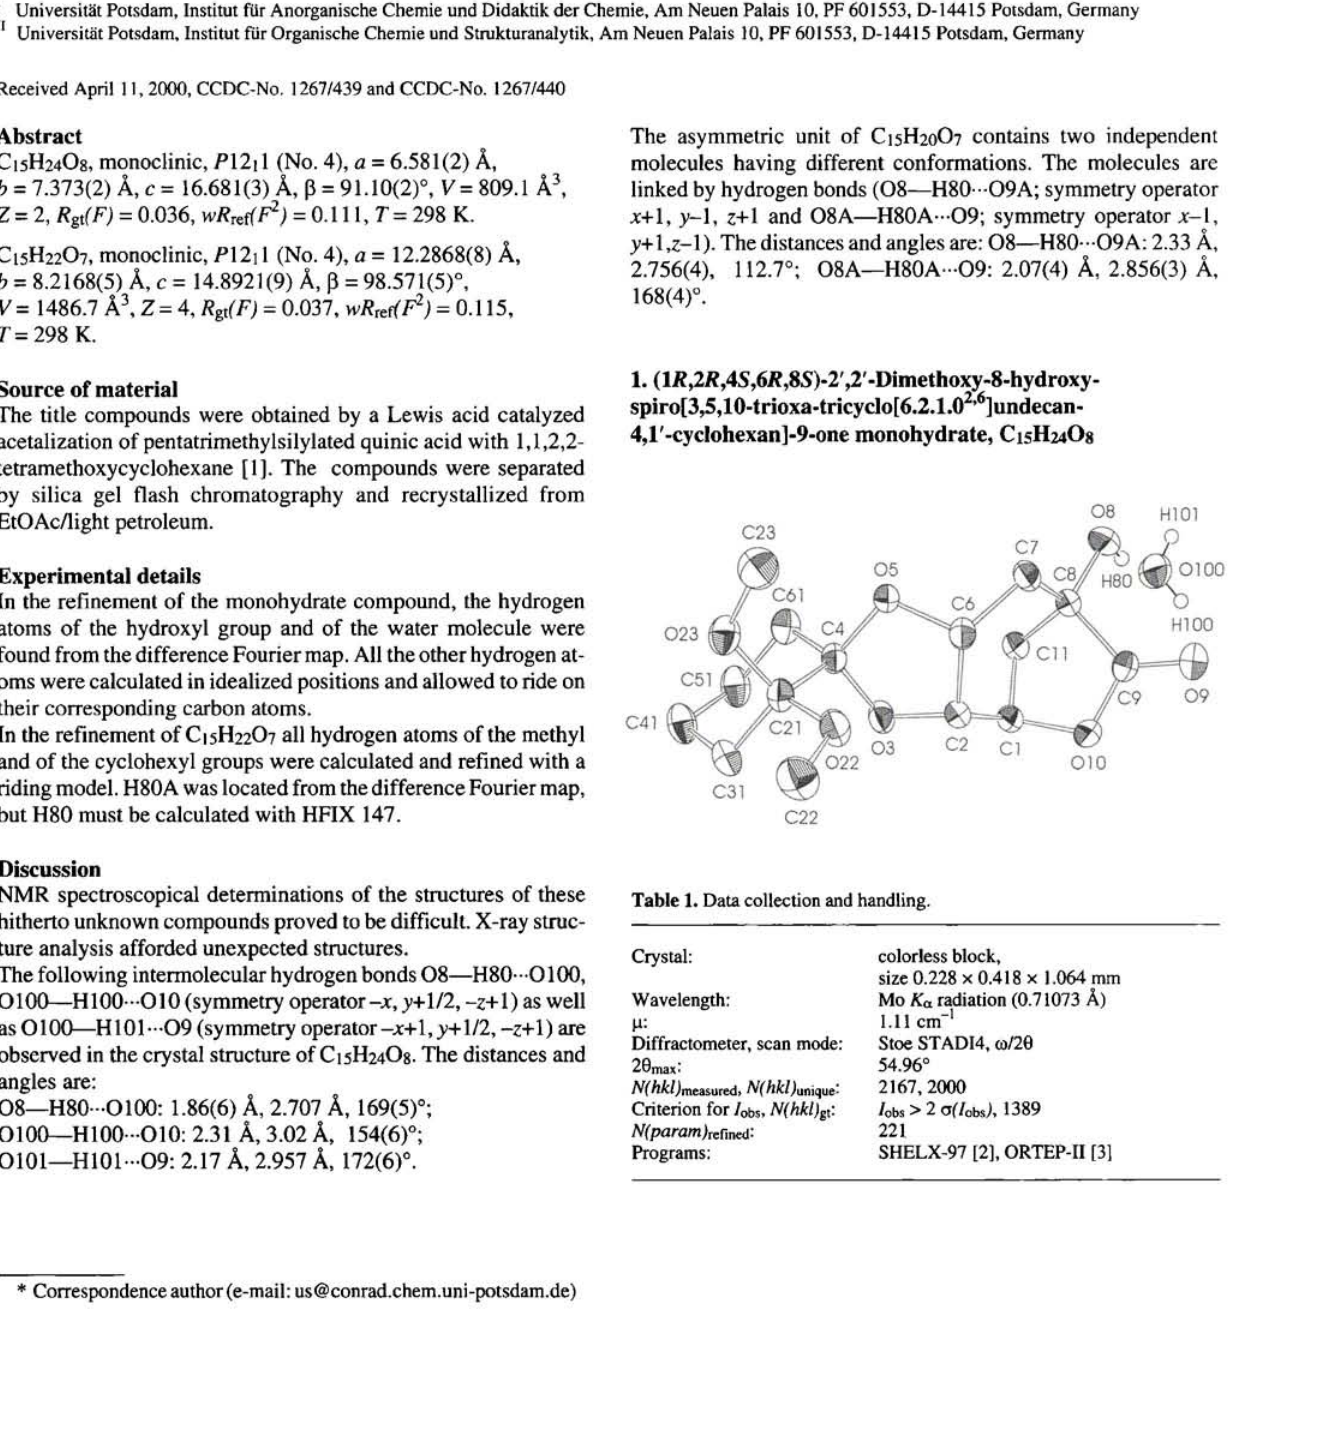
Table 1. Data collection and